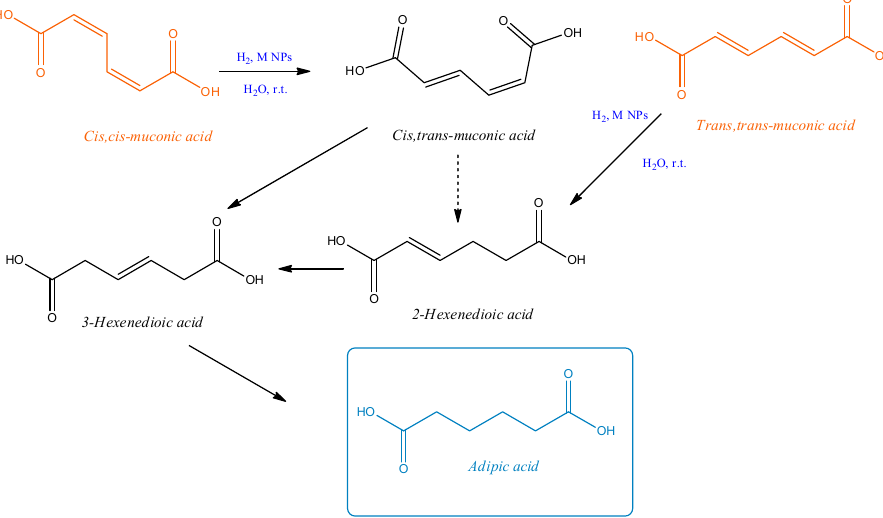
Scheme 3. The hydrogenation of muconic acids to adipic acid, in presence of M NPs (M = Pd, Pt, Ru, Rh).